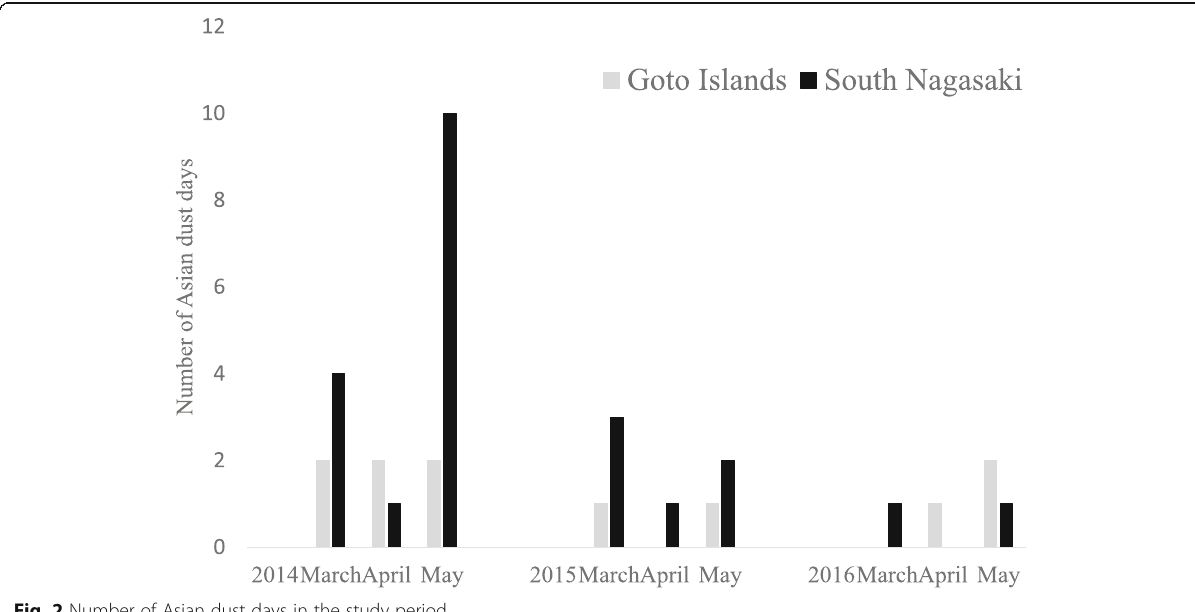
Fig. 2 Number of Asian dust days in the study period